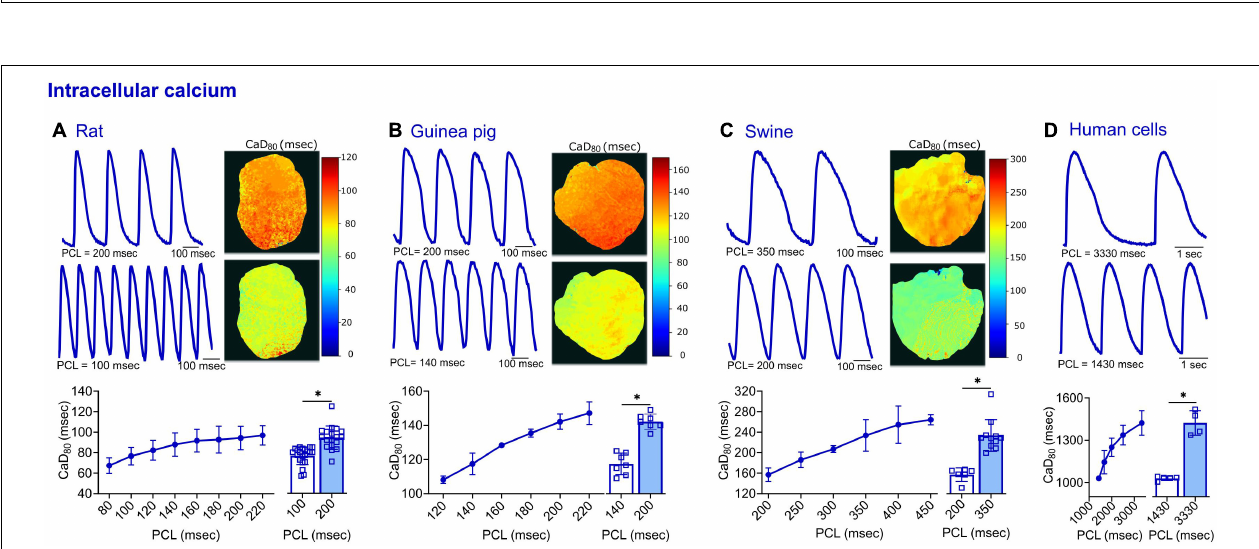
FIGURE 5 | Calcium transient measurements acquired from four different species. (A) Representative signals and CaD 80 maps from a rat heart paced at 200 and 100 ms PCL (top). Compiled restitution curve of CaD 80 , in response to dynamic epicardial pacing (bottom left, n = 11–19 independent heart preparations). Longer CaD 80 values observed at slower rates (200 vs. 100 ms PCL, n = 18–21 independent heart preparations). (B) Representative signals and CaD 80 maps from a guinea pig heart paced at 200 and 140 ms PCL (top). Compiled restitution curve of CaD 80 , in response to dynamic epicardial pacing (bottom left, n = 5–7 independent heart preparations). Longer CaD 80 values observed at slower rates (200 vs. 140 ms PCL, n = 7 independent heart preparations). (C) Representative signals and CaD 80 maps from a swine heart paced at 350 and 200 ms PCL (top). Compiled restitution curve of CaD 80 , in response to dynamic epicardial pacing (bottom left, n = 3–11 independent heart preparations). Longer CaD 80 values observed at slower rates (350 vs. 200 ms PCL, n = 6–11 independent heart preparations). (D) Representative signals from hiPSC-CM paced at 3330 and 1430 ms PCL (top). Compiled restitution curve of CaD 80 , in response to field potential stimulation (bottom left, n = 4–5 independent cell preparations). Longer CaD 80 values observed at slower rates (3330 vs. 1430 ms PCL, n = 4–5 independent cell preparations). Values reported as mean ± SD. * p < 0.05, as determined by an unpaired Student’s t -test (two-tailed).